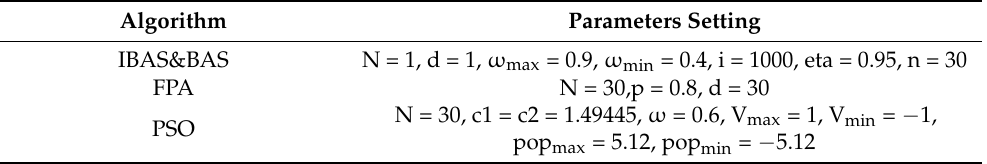
Table 2. Algorithm parameter